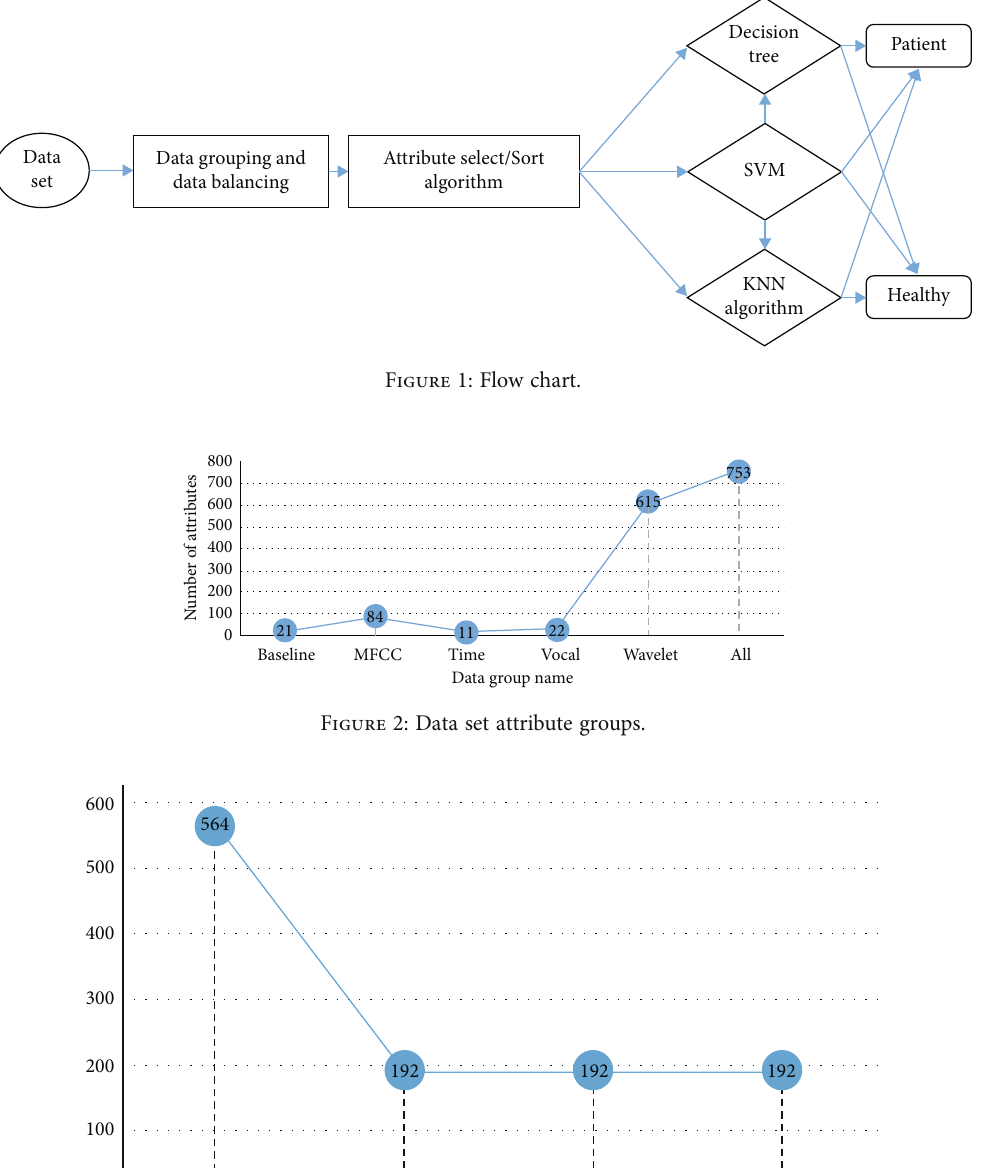
Figure 1: Flow chart.